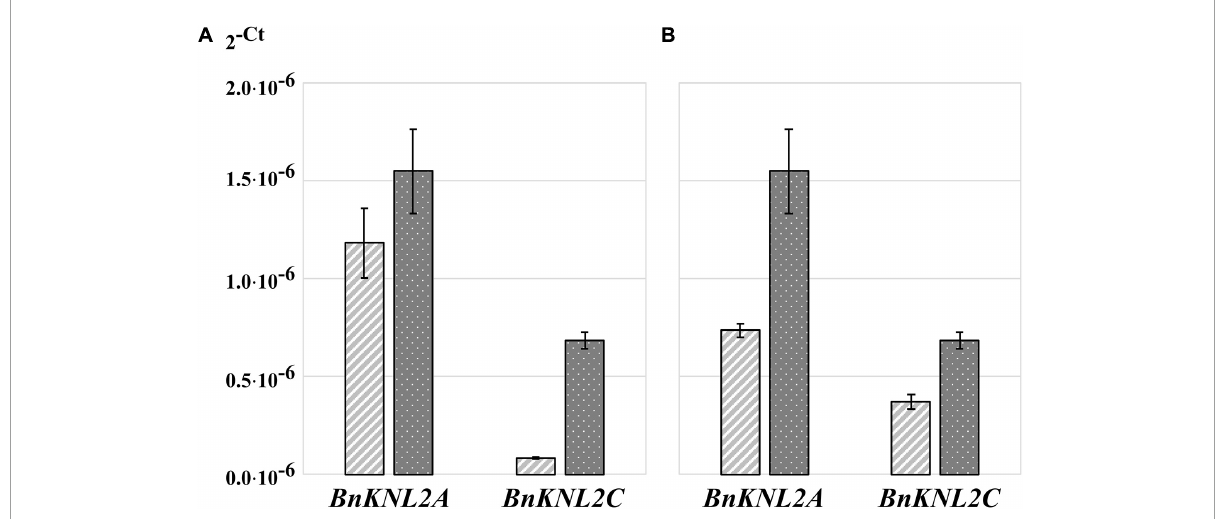
FIGURE3 Transformed cycle-threshold (2 - ct ) values of BnKNL2A and BnKNL2C transcripts in a cDNA-mix of all analyzed tissues of B. napus ( v. Palma ). (A) Influence of cDNA synthesis strategy on qPCR sensitivity, light gray—cDNA, synthetized with unspecific oligo (dT) 18 , dark gray–specific cDNA, synthetized with antisense oligonucleotides of the corresponding gene. (B) Influence of different qPCR plates on signal intensity, light gray—transparent plate, dark gray—white plate of the same manufacturer. Error bars: standard deviation of sample (N-1) N =